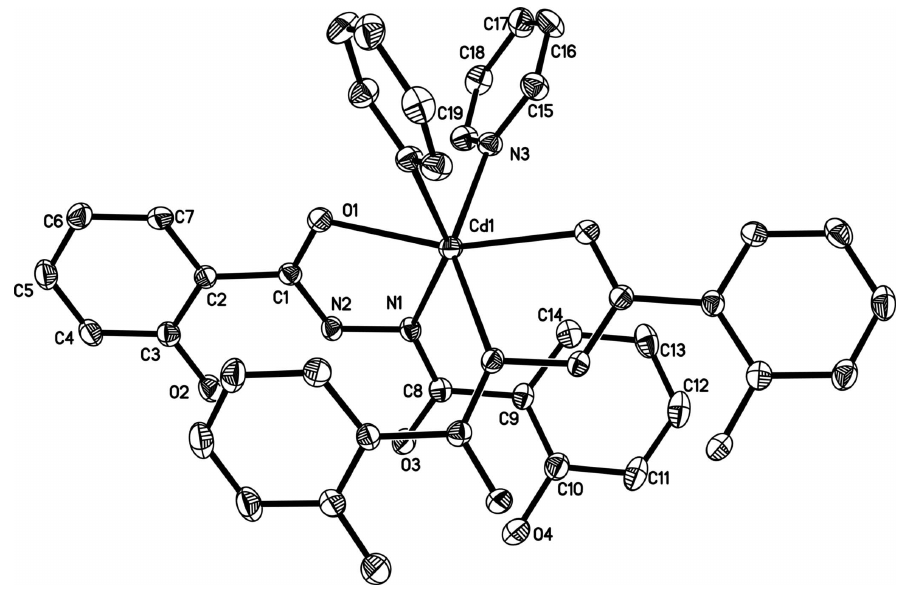
Figure 1 The molecular structure of the title complex. Displacement ellipsoids are drawn at the 30% probability level.